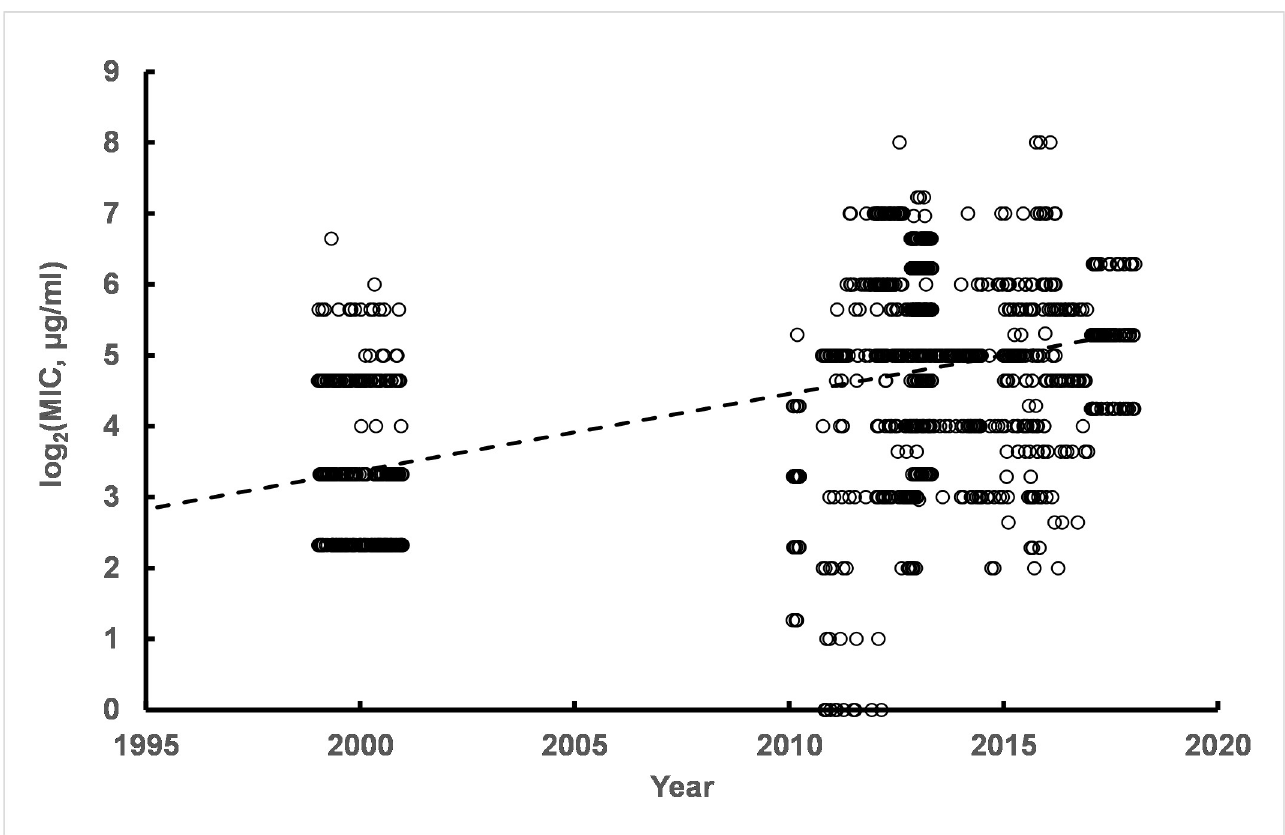
Fig 6. Time course of MICs for A . baumannii for strains from all isolation dates. Individual log 2 (MIC) values are shown for the 1277 readings reported in the publications compiled for this report. A representative example of linear regression from among 50 permutation runs (dashed line) is shown superimposed on the individual measurements. The parameters for linear regression and details of statistical analyses are given in detail in S8 Table in S2 Appendix.